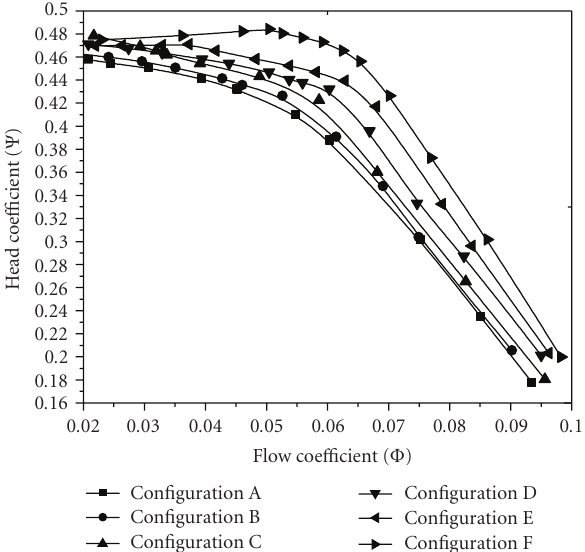
Figure 5: Performance characteristics curves for all configurations.